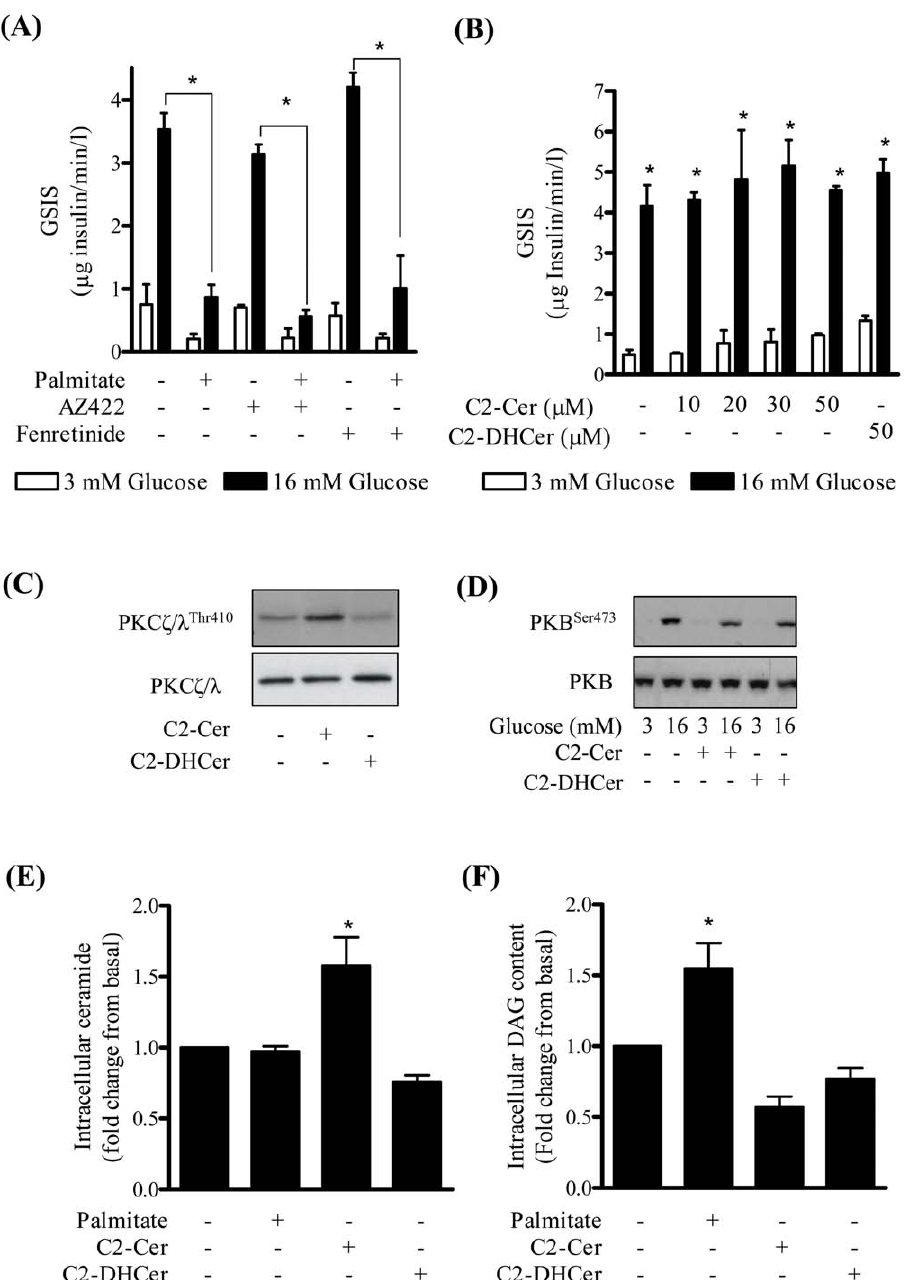
Figure 3. The denovo ceramide synthesis pathway is not involved in the palmitate-induced loss in glucose-stimulated insulin secretion. MIN6 b cellswereincubatedeitherwithor without10 m MAZ422(aSPTinhibitor) or5 m Mfenretinide(aninhibitorofdihydroceramide desaturase) (A) for 48 h or with varying concentrations of ceramide and dihydroceramide (B–F) for 2 h. Palmitate (0.4 mM) was present for 48 h where indicated. Glucose was addedfor1 hforanalysisofGSIS(AandB). Alternatively,cellswereeitherlysedfor immunoblotanalysis usingantibodies against(C)PKC f / l Thr410 andtotal PKC f / l (used as loading control), (D) PKB Ser473 and total PKB (as a loading control) or harvested and lipids extracted to assess (E) ceramide or (F) DAG content. Bars represent mean 6 SEM of 3 experiments and asterisks signify a significant difference from the untreated control value (P ,